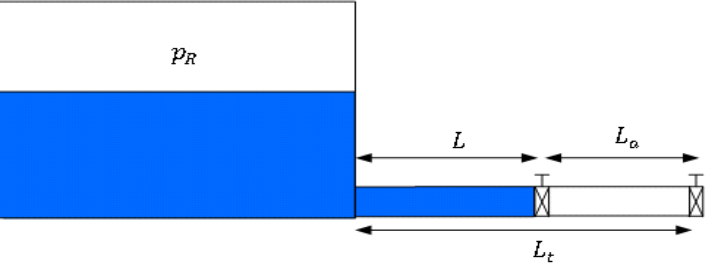
Figure 1. The schematic of a horizontal reservoir-pipe system with constant driving pressure. The momentum equation for a horizontal water column is,